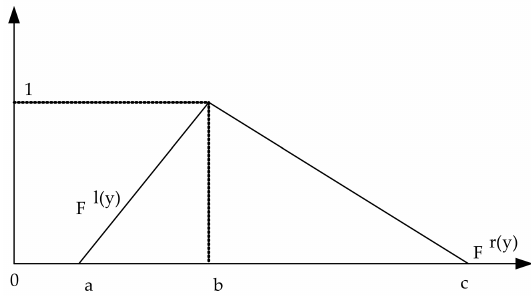
Figure 4. Triangular Fuzzy